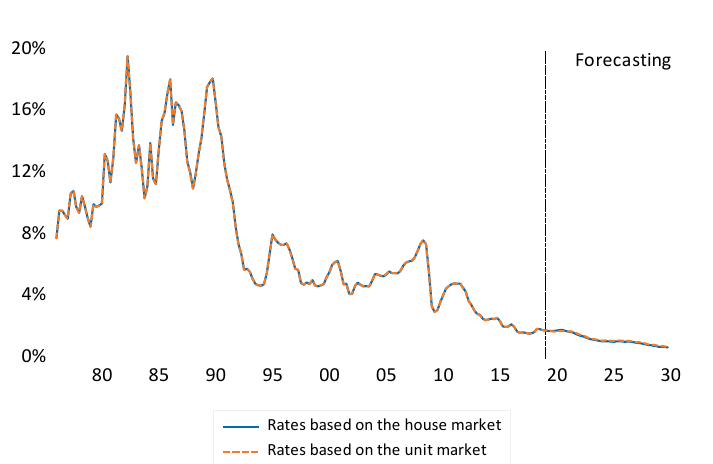
Figure A2. Forecasted Interest Rates.